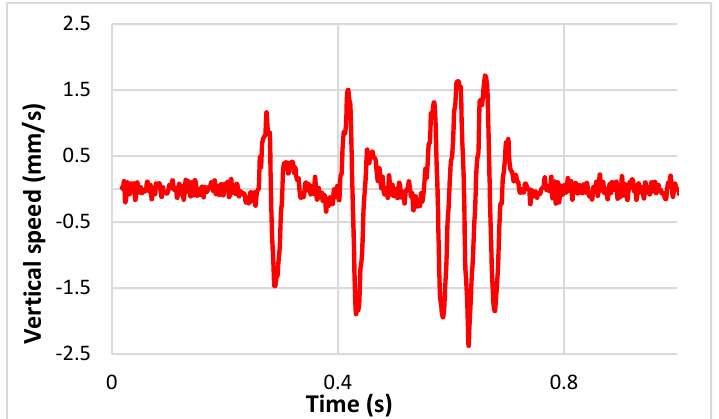
Figure 5. Geophone GS11D signal after filtering.